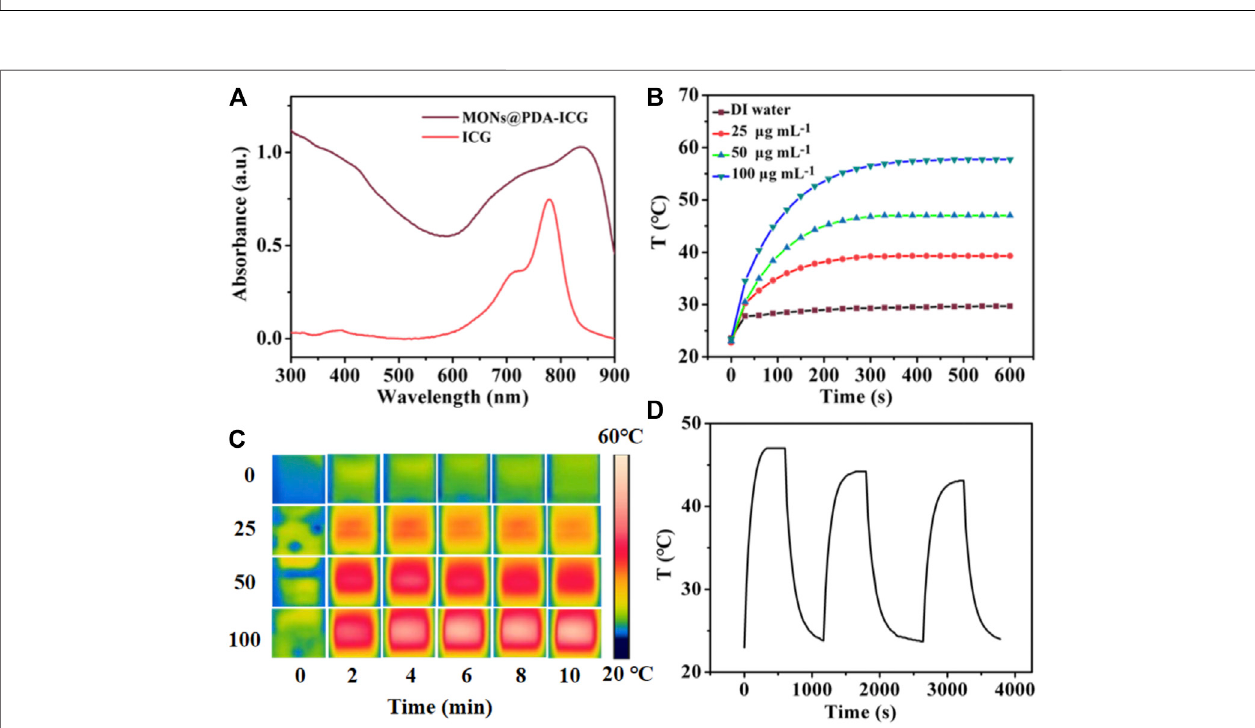
FIGURE 4 | (A) UV-vis absorption spectrum of MONs@PDA-ICG and Free ICG. (B) Temperature curve of MONs@PDA-ICG with different concentrations under 808 nm laser (1.5 W cm − 2 ) for 10 min (C) Infrared thermal images every 2 min. (D) Cycle curve of MONs@PDA-ICG at 50 μ g mL − 1